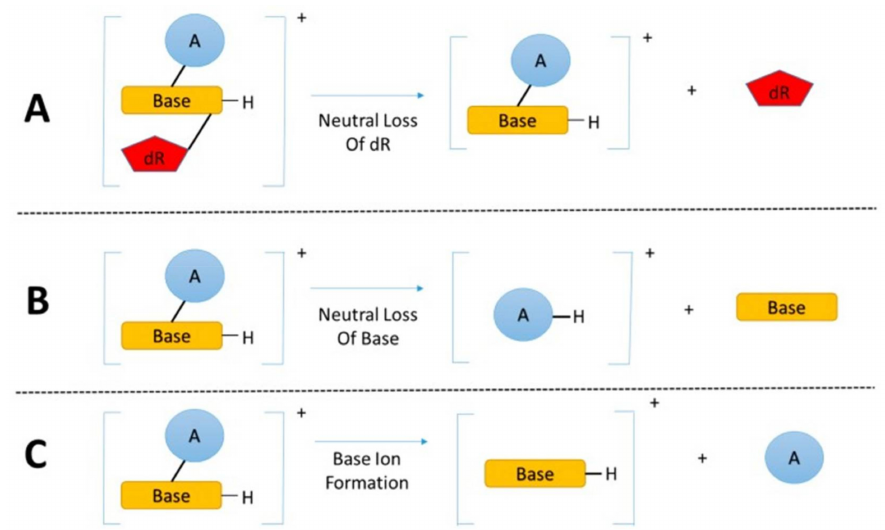
Figure 2. The fragmentation pathways of modified nucleosides analyzed by LC-MS. ( A ) The major fragmentation of the modified nucleosides is the neutral loss of deoxyribose. Other common fragmentations include ( B ) the neutral loss of base and ( C ) the neutral loss of the adduct with the formation of base ions